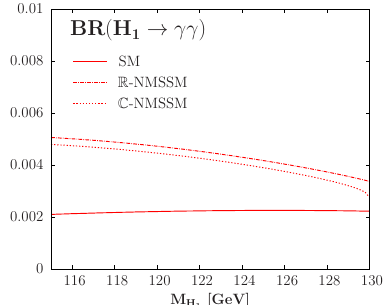
Figure 5. The decay branching fraction of the lightest Higgs γγ as a function of the Higgs mass M H state H 1 into → GeV). The full line is the SM prediction, the dashed-dotted line is the R –NMSSM prediction and the dotted line is the C –NMSSM